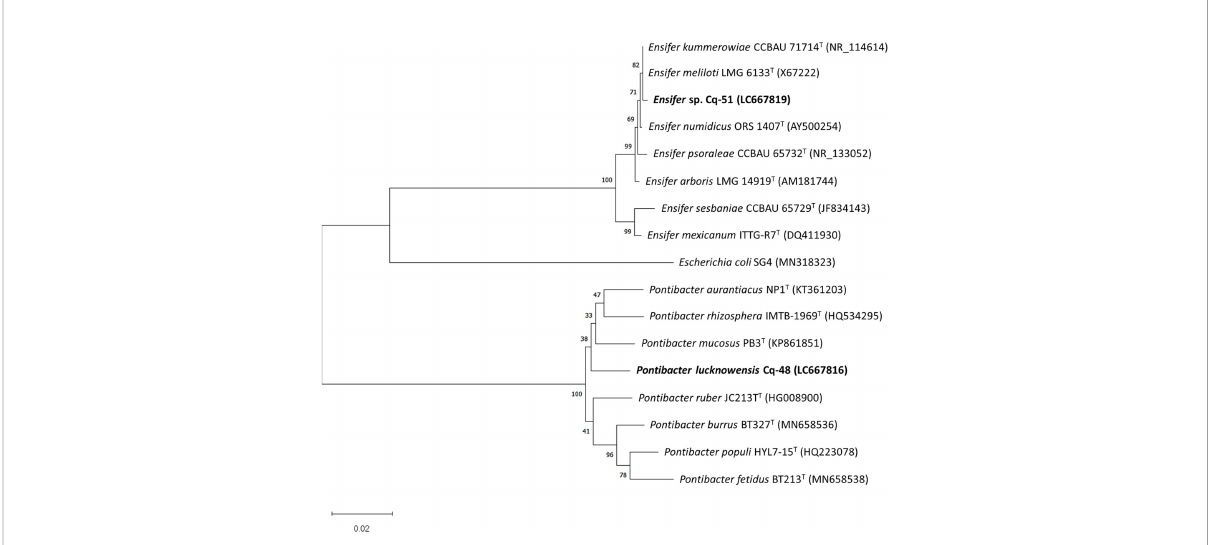
FIGURE 3 Phylogenetic tree of the strains Cq-32 and Cq-40 and related type strains within families of Rhizobiaceae and Cytophagaceae based on partial 16S rRNA gene sequences. The neighbor-joining algorithm constructed the tree in MEGA_X.